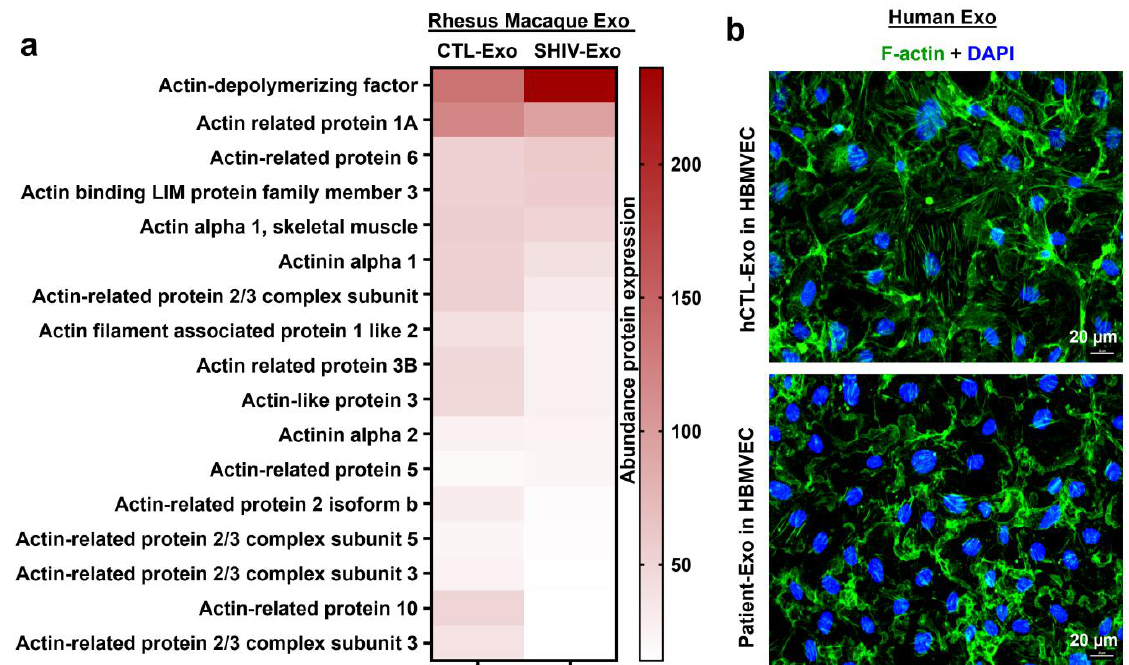
Figure 10. Differential expression of actin cytoskeleton proteins in RM plasma exosomes and the